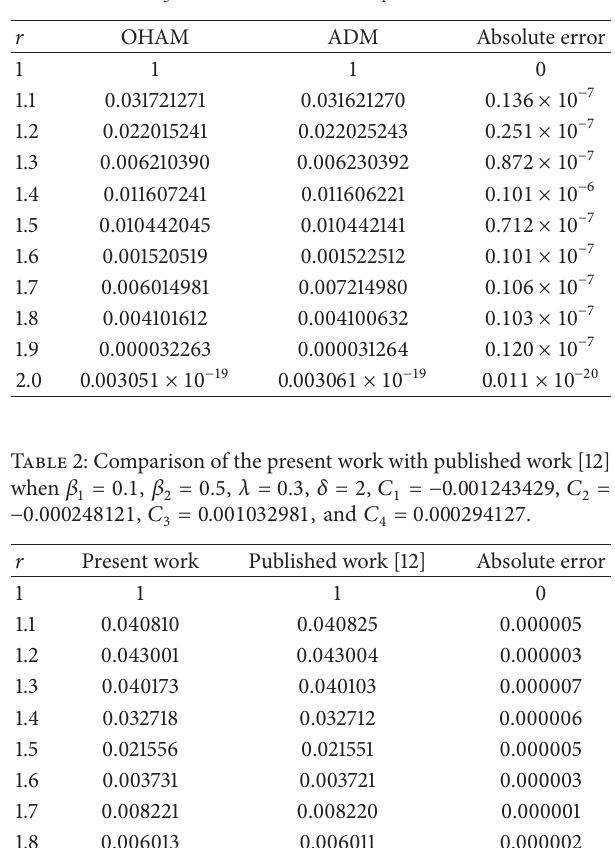
Table 1: Numerical comparison of OHAM and ADM when 𝛽 1 = 0.1